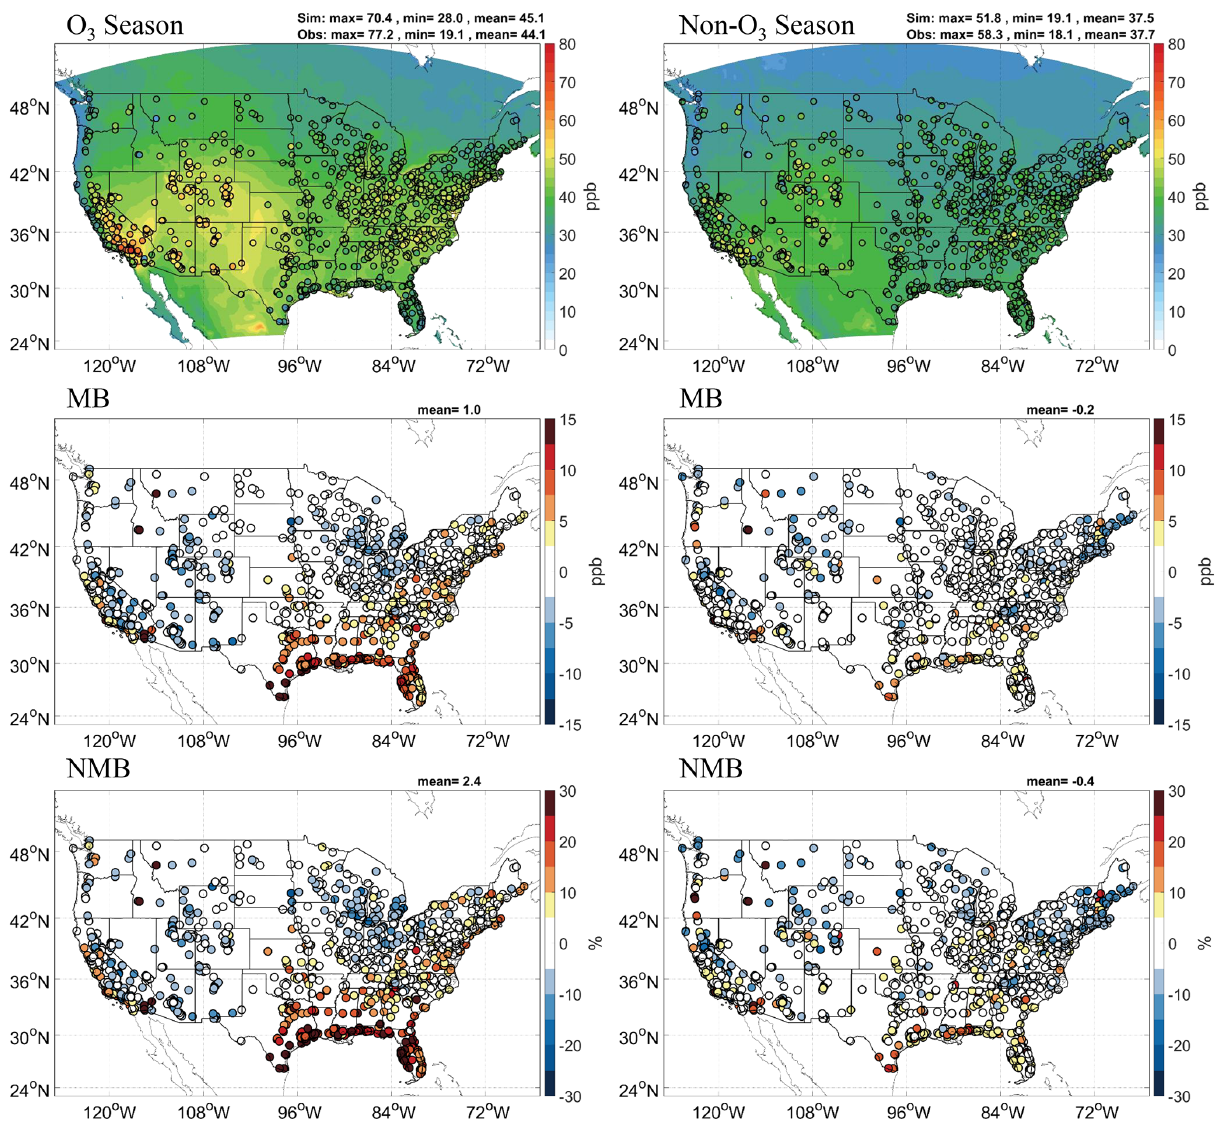
Figure 2. Spatial distribution of forecasted MDA8, MB, and NMB during the O 3 and non-O 3 seasons. Observation from AIRNow is shown as filled circles in the overlay plots of